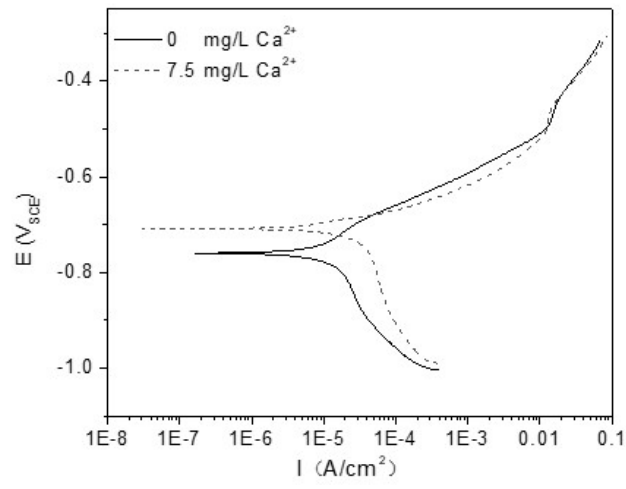
Figure 7. Effect of Ca 2+ addition on the electrochemical behavior of the P110 steel.